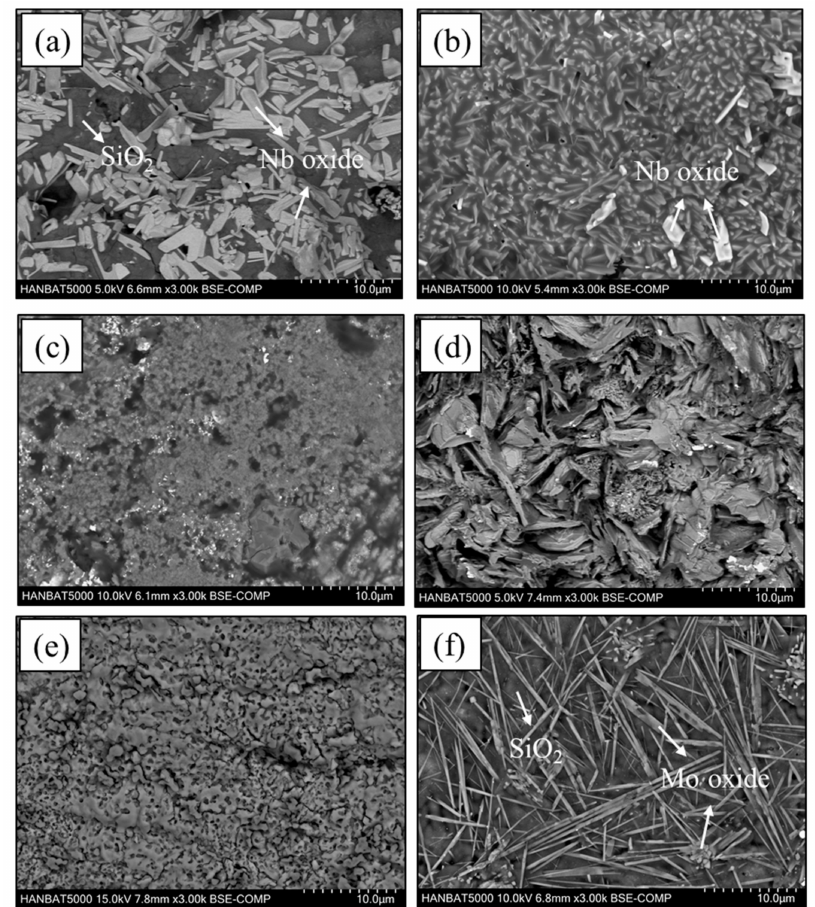
Figure 6. SEM image of the surface of Si-pack-coated specimens after oxidation tests at 1200 ◦ C for 6 h with substrate compositions of ( a ) Alloy 1 (Nb), ( b ) Alloy 2 (Nb 73.6 Mo 26.4 ), ( c ) Alloy 3 (Nb 51.2 Mo 48.8